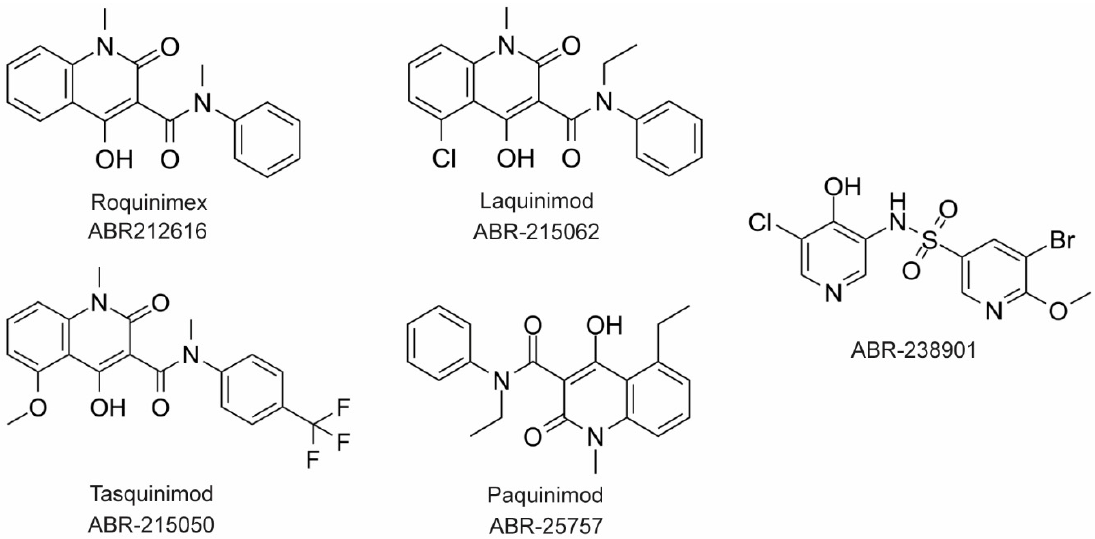
Figure 4. Chemical structures of Active Biotech CP inhibitors reported to date.